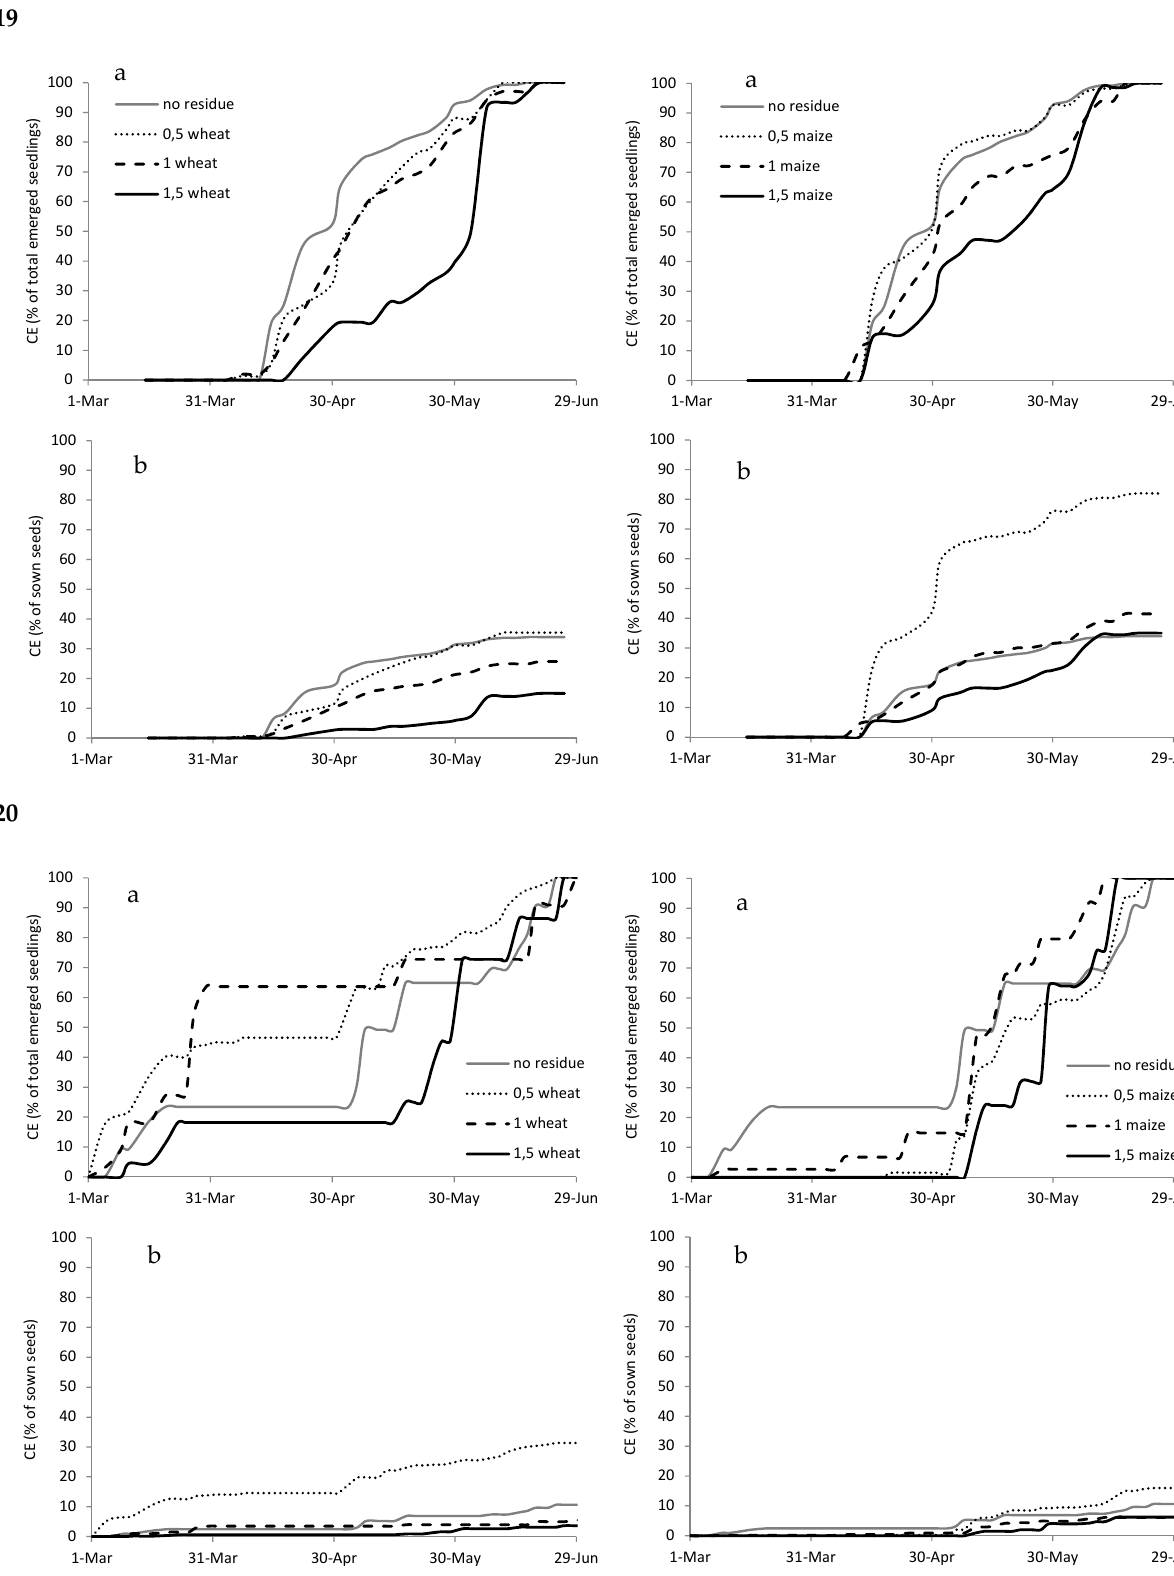
Figure A1. Cumulated emergence (CE) expressed as percentage of total emerged seedlings ( a ) and as percentage of sown seeds ( b ) of Abutilon theophrasti in 2019 and 2020 with different types (wheat on the left and maize on the right) and amounts of crop residues.